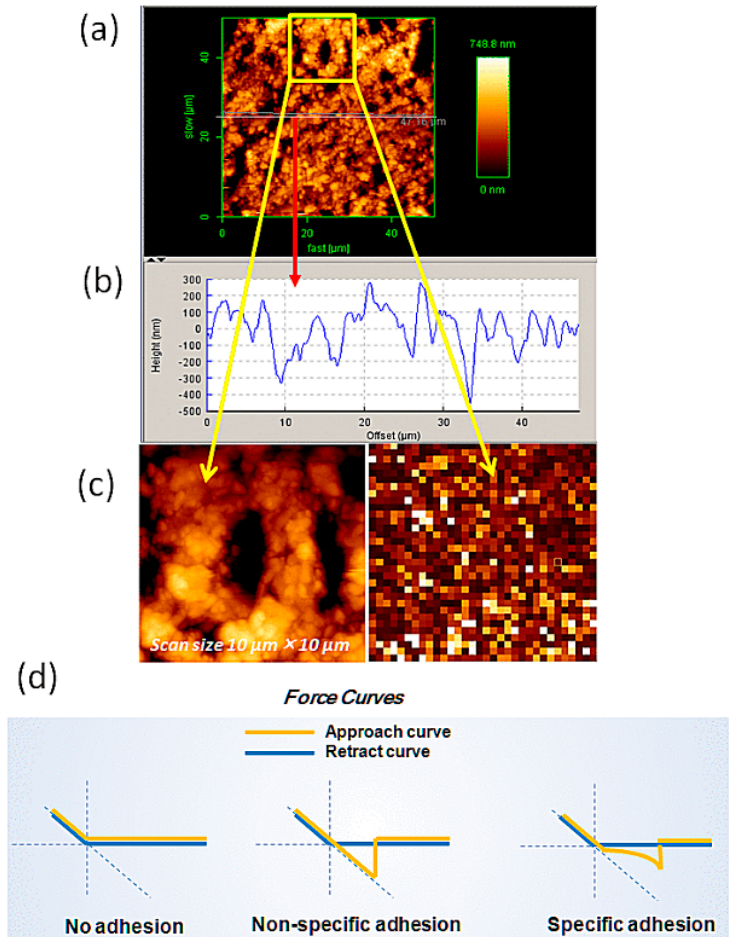
Figure 2. AFM topography of a cut pyrite inner surface taken using the contact mode. ( a ) Height image of 50 µm × 50 µm area, the vertical color scale is from 0 to 748.8 nm; ( b ) cross section of the surface area of pyrite along the center horizontal line in ( a ) under AFM. The surface was not quite as flat as a cleaved mica or graphite surface but it was possible to perform force curve measurements using an AFM probe; ( c ) a zoom-in of the height image and its force map image from ( a ) (marked as yellow box); and, ( d ) schematic examples of force curves for no-adhesion, non-specific adhesion and specific adhesion respectively.